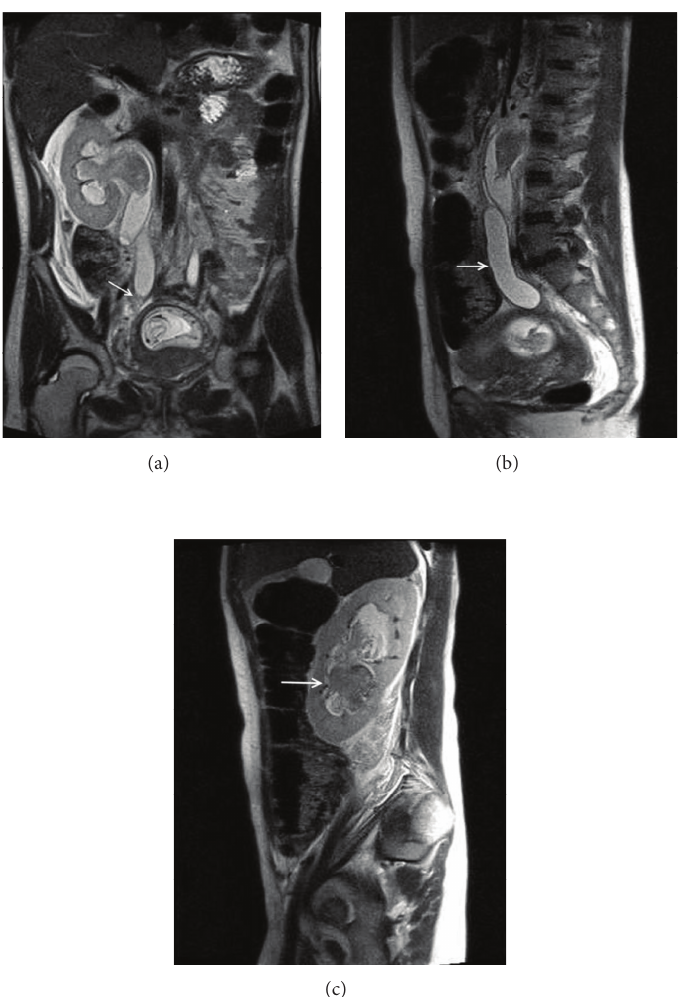
Figure 1: (a) MRI (coronal view) demonstrating high-grade stenosis of right distal ureter (arrow). Gravid uterus is also seen. (b) Sagittal view of tortuous left hydroureter (arrow). (c) Sagittal view of left hydronephrosis with blood (arrow) in the collecting